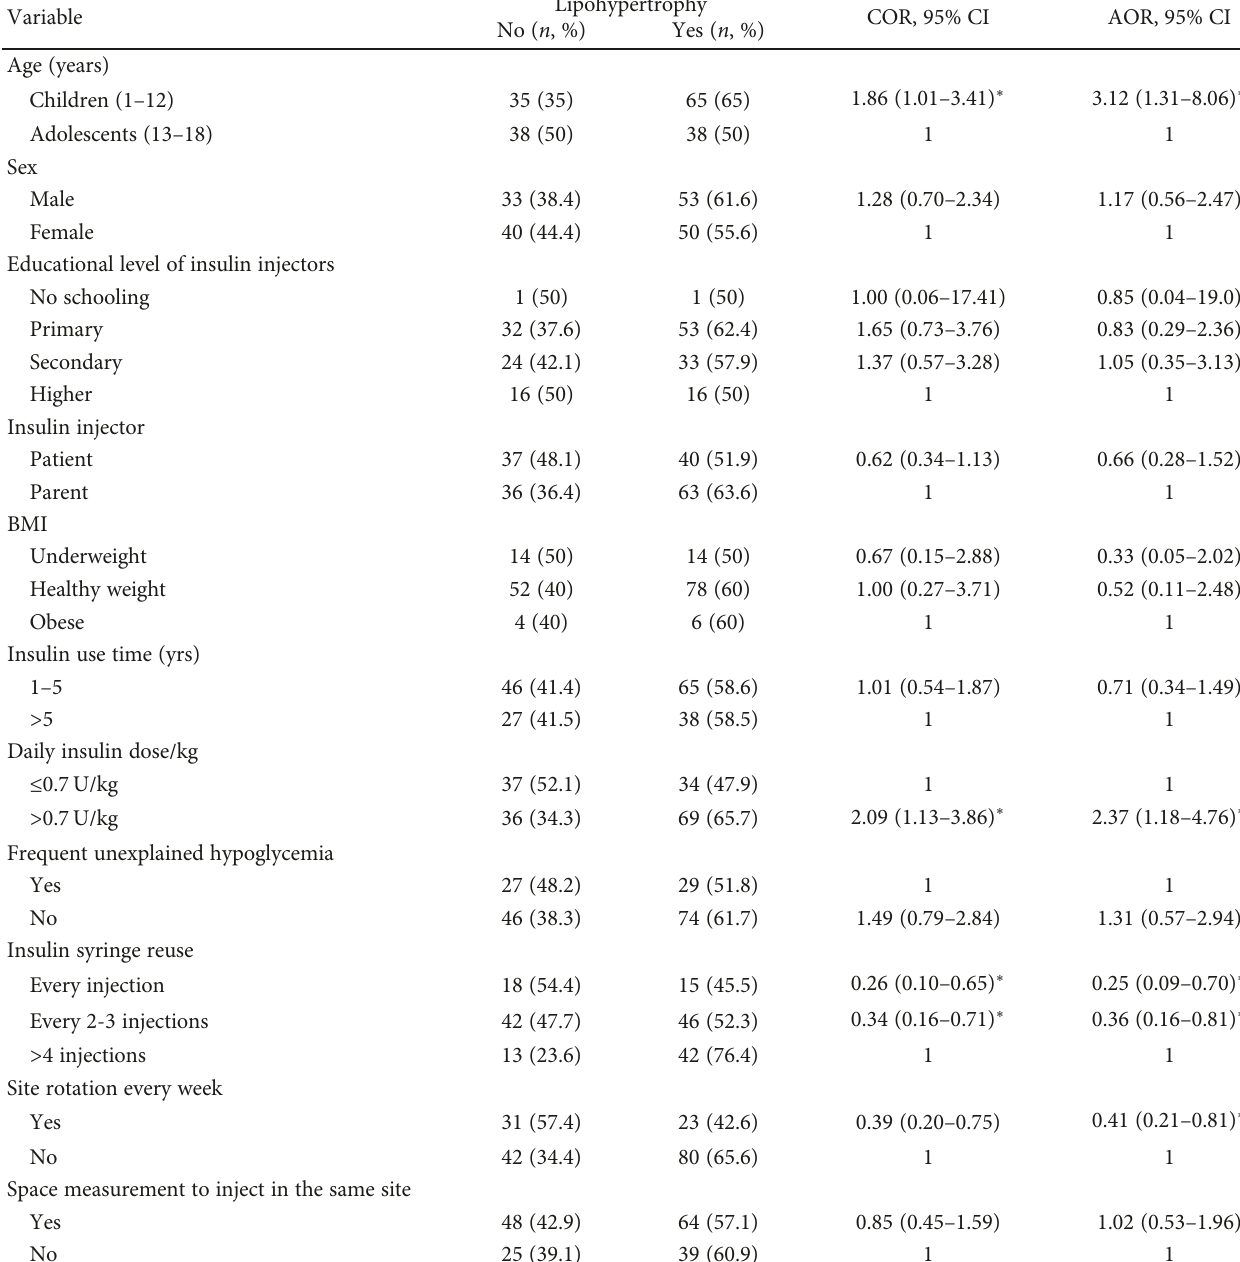
Table 1: Insulin-induced lipohypertrophy by di ff erent variables among type 1 diabetic